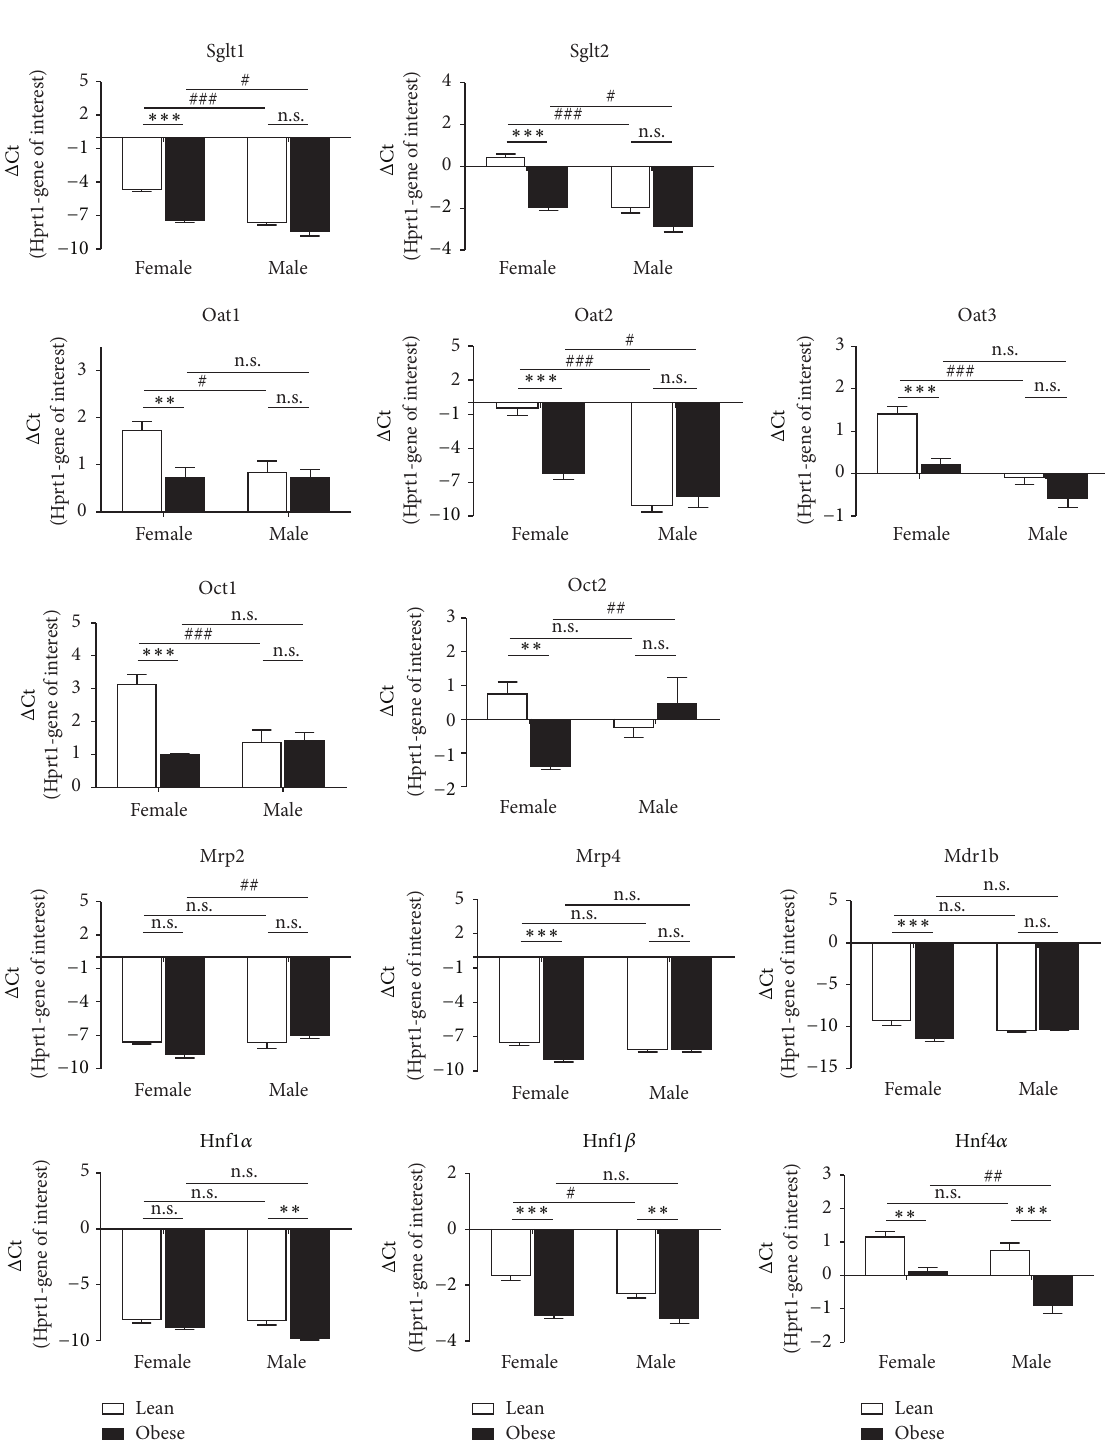
Figure 2: Diabetes- and sex-dependent renal gene expression in lean (le) and obese (ob) ZSF1 rats. Gene expressions were analyzed using TaqMan real-time PCR and presented as mean ± SEM. 𝑛 = 6 – 8 . n.s., not significant; ∗∗ 𝑃 < 0.01 ; and ∗∗∗ 𝑃 < 0.001 , for the comparison of Δ Ct values between lean and obese ZSF1 rats. # 𝑃 < 0.05 ; ## 𝑃 < 0.01 ; and ### 𝑃 < 0.001 , for comparison of Δ Ct values between females and